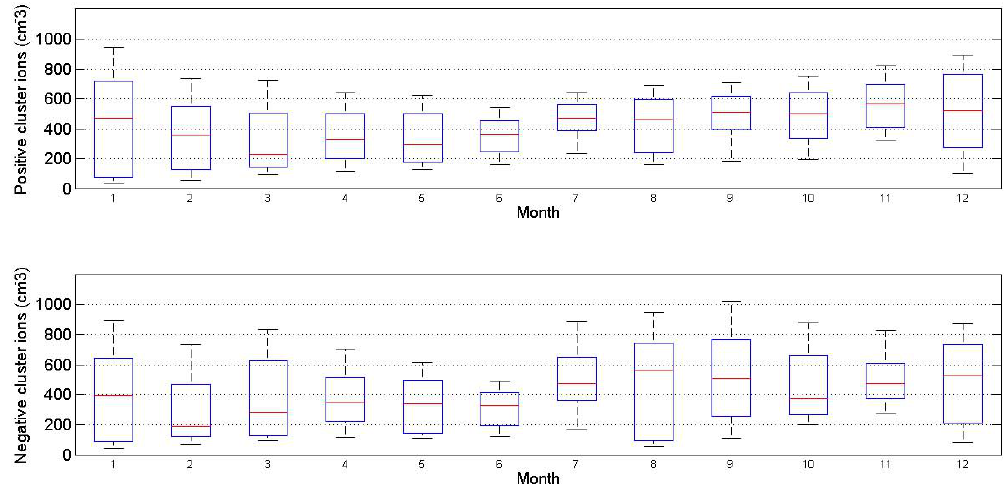
Fig. 2. Annual variation of cluster ion (0.8–1.9nm) concentration. Red line represents the median value, bottom and top sides of the blue boxes symbolize the 25th and 75th percentile, respectively, and the extremities of the black lines stand for the 10th and 90th percentile. Statistics are based on hourly median concentrations. February 2007–February 2012, Puy de Dôme.